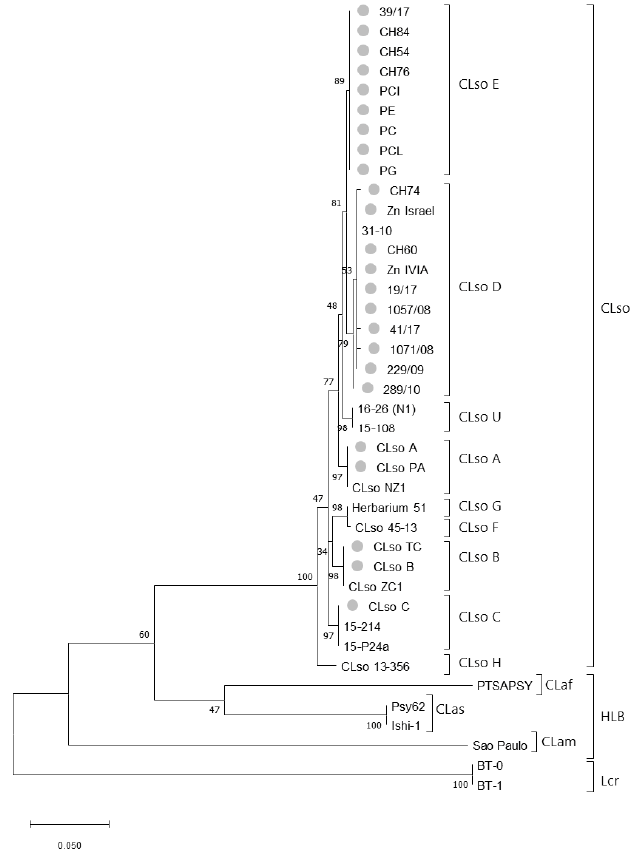
Figure 1. Phylogenetic tree of Liberibacter strains based on partial sequences of the 50S ribosomal proteins L10/L12 genes ( rplJ/rplL ). The tree was based on nucleotide sequences from 39 isolates and 453 nt positions. Analysis was performed using the Maximum Likelihood method and the Tamura-Nei model [28]. Bootstrap values (1000 replications) are shown at the branch points. Grey circles indicate those samples sequenced in this work. Phylogenetic analyses were conducted in MEGA X [27].